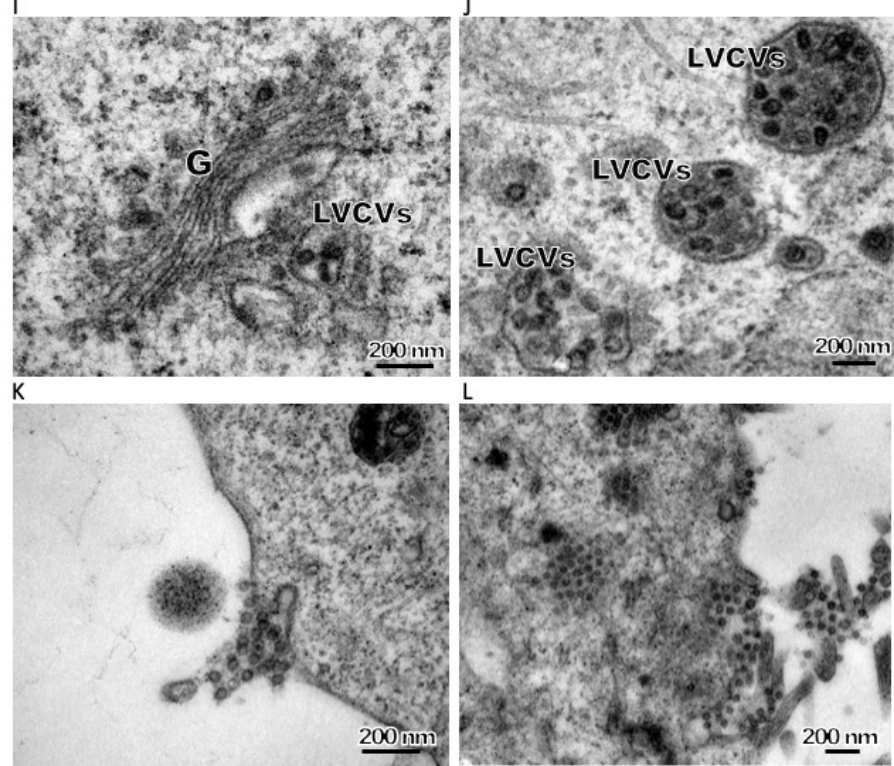
Figure 2. Electron microscopy (EM) observation of in vitro PDCoV infection: entry, assembly and maturation of PDCoV particles. LLC-PK1 were infected ( A , B ) with PDCoV or mock-infected ( C , D ) at 8 h post-infection (hpi). ( B , D ) Zoomed region highlighted in Figure A and C respectively. Compared with mock-infected cells large amounts of vesicles, including double-membrane vesicles (DMVs), zippered endoplasmic reticulum (ER) and injured mitochondria, are visible in the cytoplasm. ( E ) Viral particles in the process of attachment on the cell membrane at 4 hpi, and one viral particle likely in the process of endocytosis at 4 hpi. ( F ) One viral particle is likely in the process of endocytosis at 4 hpi. ( G ) Precursor PDCoV virions assembled predominantly in the rough endoplasmic reticulum (RER) nearby DMVs (white arrow, hpi = 6). ( H ) Precursor virions assembled in the RER or ERGIC. Precursor particles were observed in the dilated RER (white arrow) (hpi = 8). ( I ) Precursor virions likely completed the structural transformation that yielded small-size virions. Large virion-containing vacuoles (LVCVs) are thought to originate from Golgi compartments that expand to accommodate numerous virions (hpi = 16). ( J ) LVCVs are large circular organelles with a diameter of approximately 400–600 nm that contain numerous virions in their interior (hpi = 16). ( K ) Virion-containing vesicles fuse with plasma membranes and then released the virus particles to the extracellular environment without damage to the cell in the first few replicative cycles (hpi = 12). ( L ) Large amounts of viral particles released by cytolysis (hpi = 24). ER: endoplasmic reticulum, M: mitochondria, N: nucleus, G: golgi